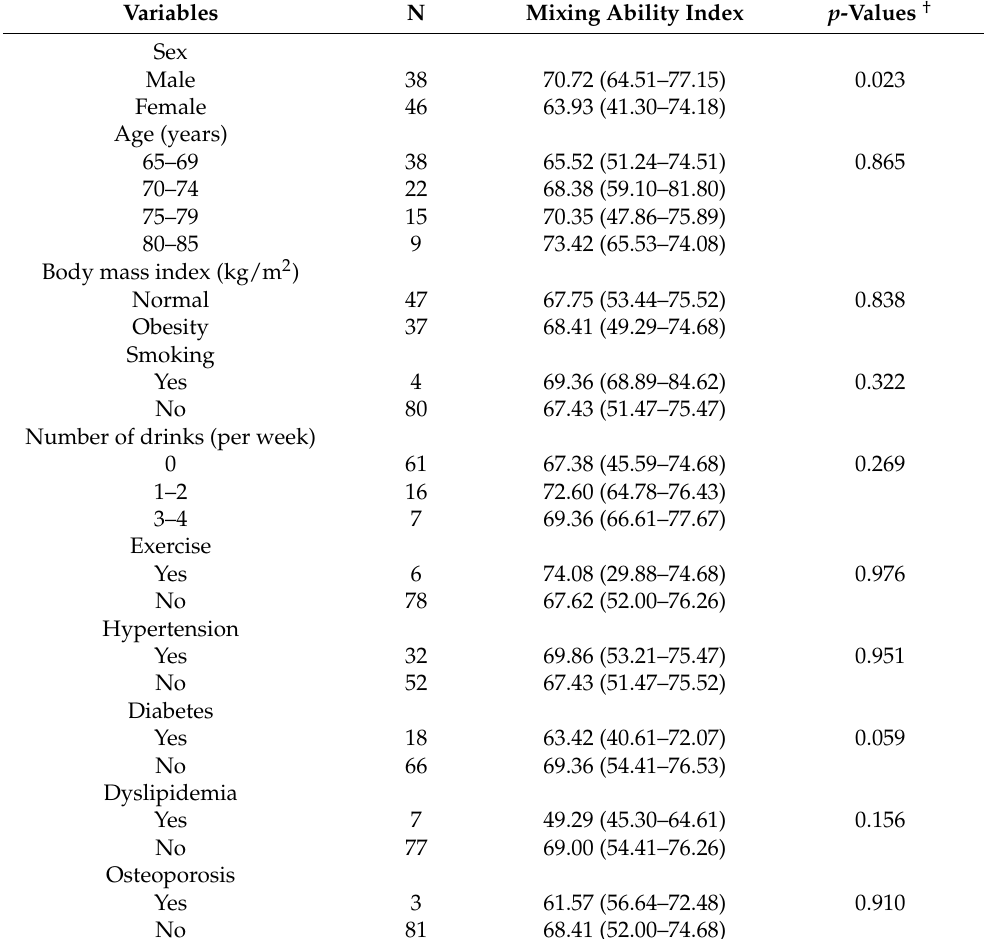
Table 2. Mixing ability index-related variables.